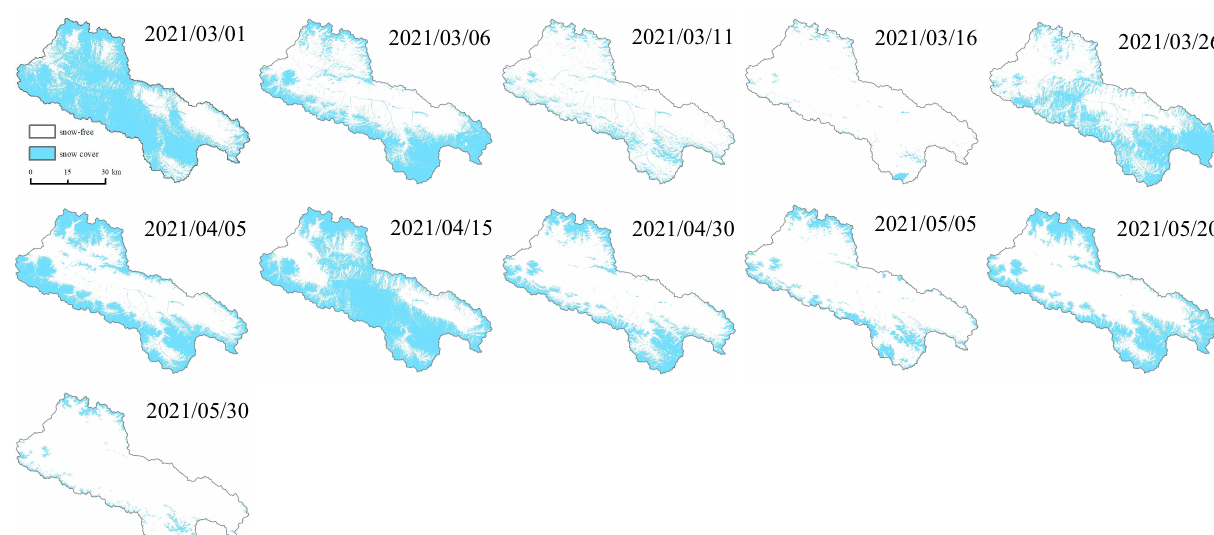
Figure 8. Spatial variation of snow cover during ablation period